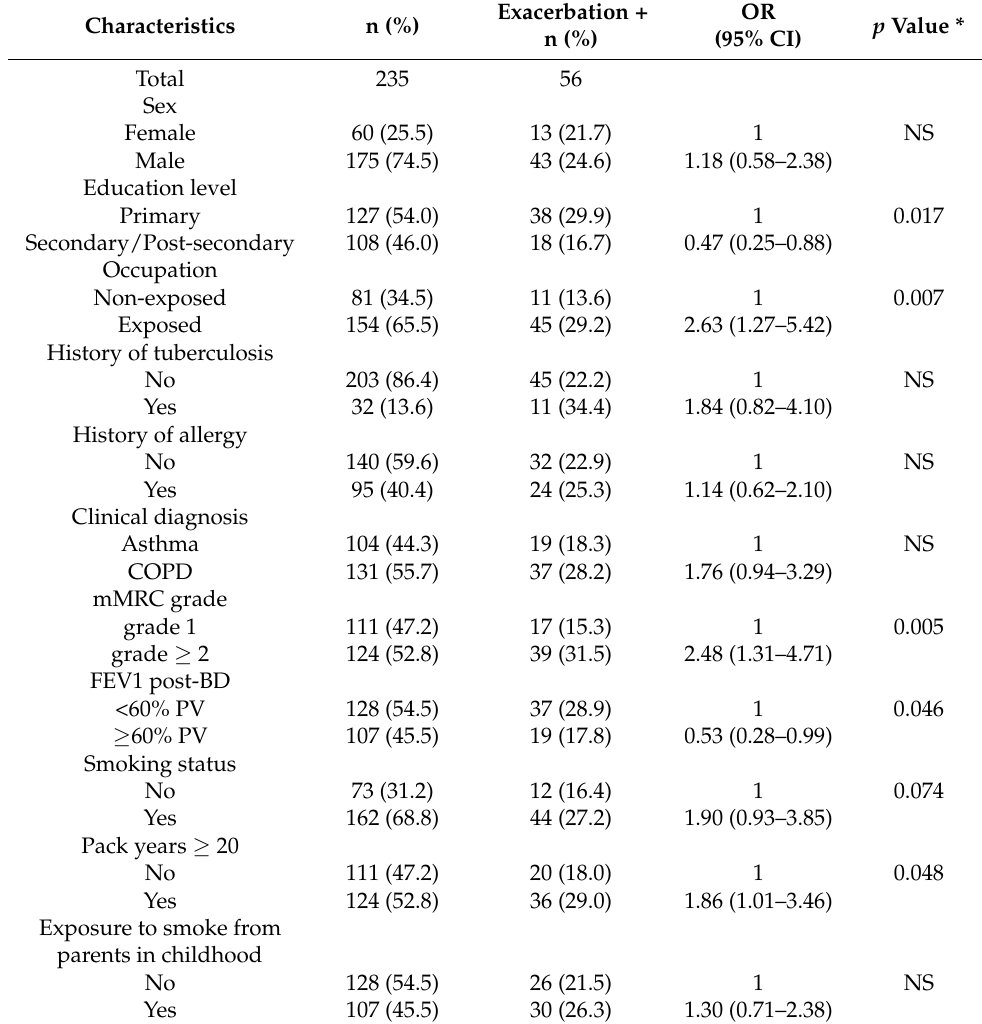
Table 1. The risk of exacerbations in regard to demographics, education and occupation, clinical status, spirometry and smoking